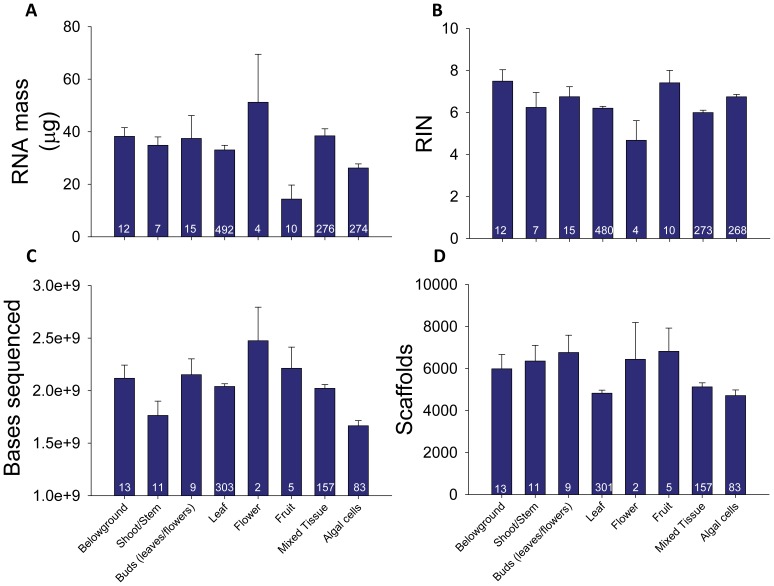
Variation among tissue types in RNA quality and transcriptome size.We observed differences among tissue types for (A) total RNA mass (µg) isolated, (B) RIN, (C) sequencing depth and (D) number of scaffolds. For each tissue, we show the mean +1 SE and sample size at the base of columns. A posteriori pairwise contrasts among means corrected for multiple comparisons are shown in Supplemental Tables 3 and 5.